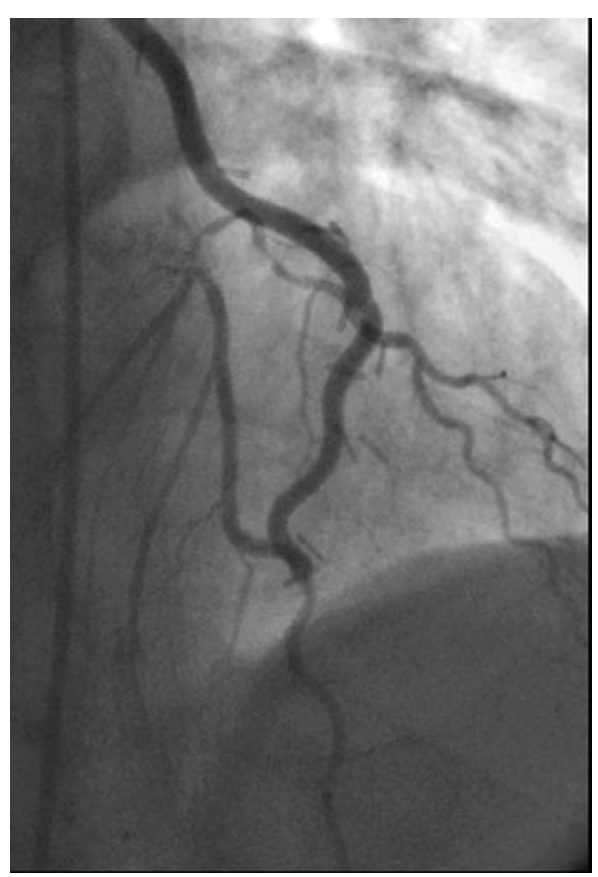
Fig. 5 - Angiografia pós-operatória tardia demonstrando anastomose seqüencial de ATIE para coronárias DI e DA.